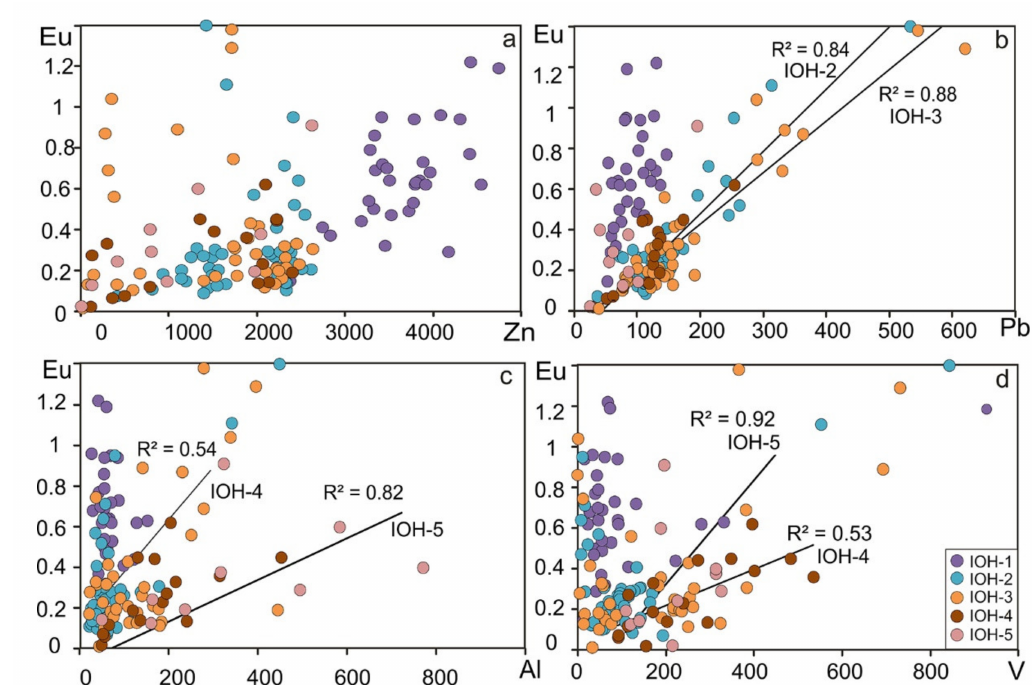
Figure 11. Bivariate plots of: ( a ) Zn vs. Eu; ( b ) Pb vs. Eu; ( c ) Al vs. Eu and ( d ) V vs. Eu for the iron oxyhydroxides (IOH) types of the Pobeda-1 hydrothermal field